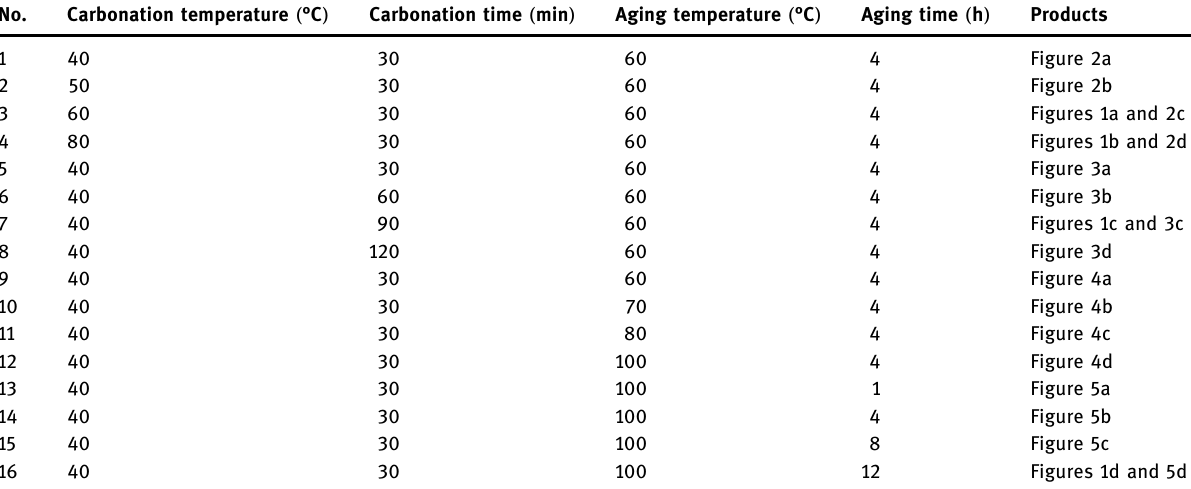
Table 1: Conditions of magnesium carbonate hydrate prepared during talc carbonation No. Carbonation temperature ( °C